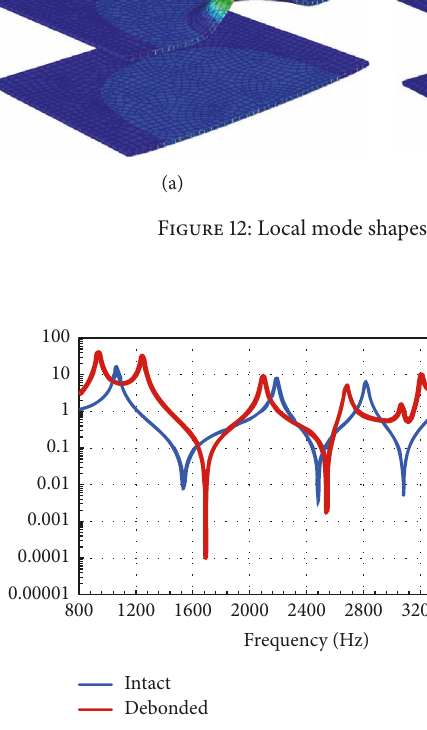
Figure 13: The FRFs obtained at the centre of the top face sheet of debonded and the same intact sandwich